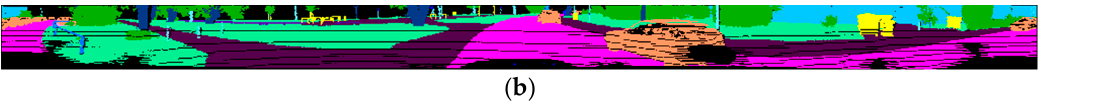
Figure 2. LiDRA projection. ( a ) Original point clouds with ground truth labels; ( b ) Projected ground truth labels.